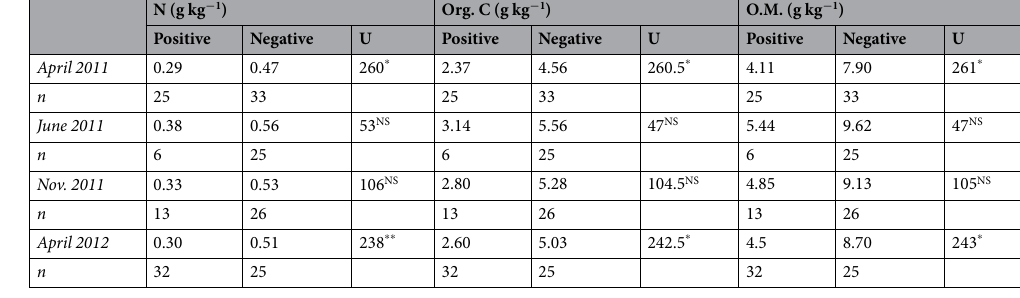
Table 3. Nitrogen (N), organic carbon (Org. C) and organic matter (O.M.) contents of B. pseudomallei positive and negative samples; U: Mann-Whitney’s U test; n: sample size; significance level: NS: non significant; * p < 0.05, ** p <